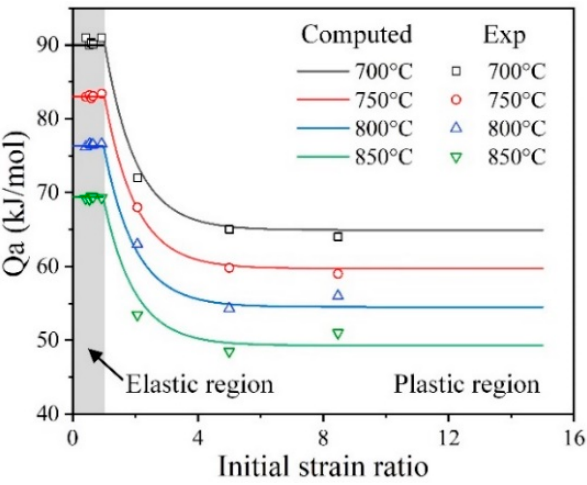
basis for the parameter calibration of the model.